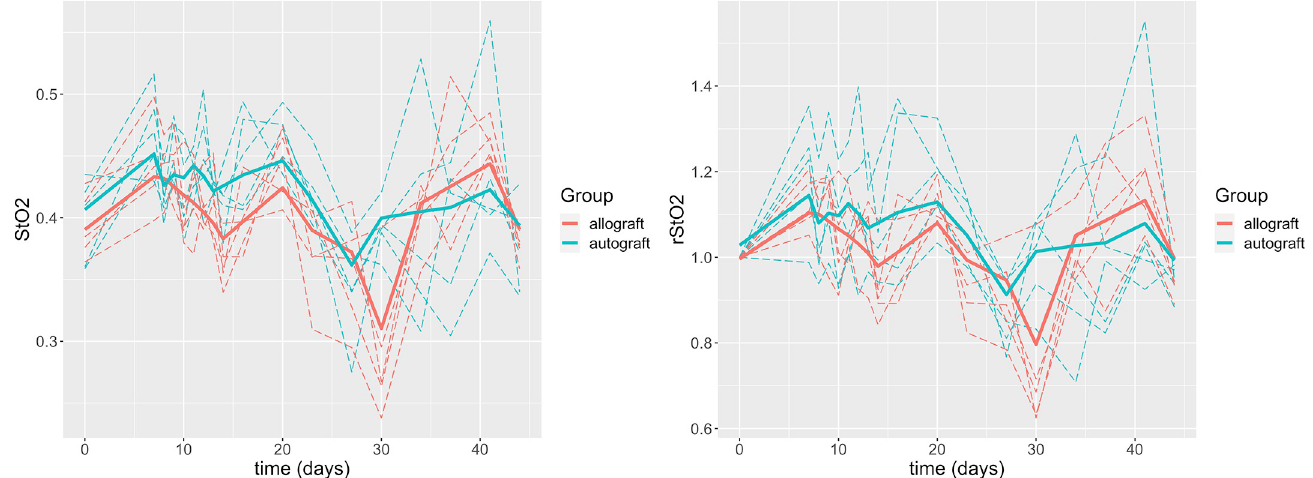
Fig 6. (a) Estimated StO 2 trajectories over time by SMM (thick curves) for the allograft group (red) and the autograft group (blue) at γ = 0.5. The dashed curves are the observed StO 2 trajectories of individual mice in each group. (b) Estimated rStO 2 trajectories over time by SMM (thick curves) for the allograft group (red) and the autograft group (blue) at γ = 0.5. The dashed curves are the observed rStO 2 trajectories of individual mice in each group.